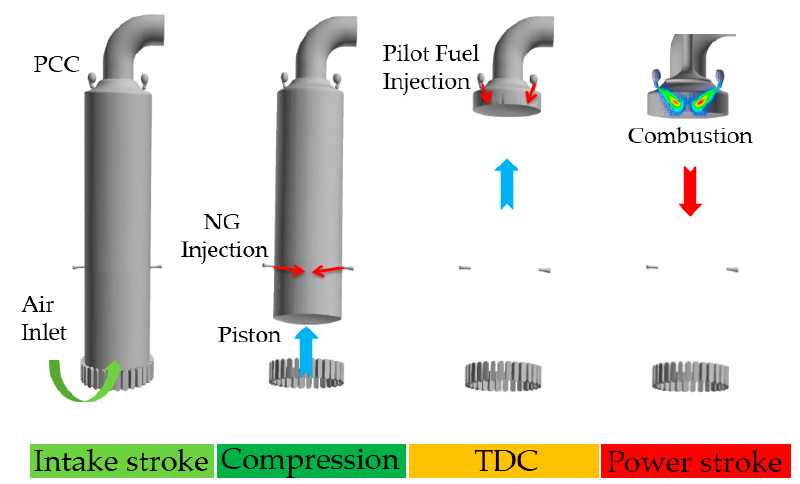
Figure 3. Cylinder work of a LP-DF engine (PCC: Pre-combustion chamber, NG: Natural gas, TDC: Top dead center).